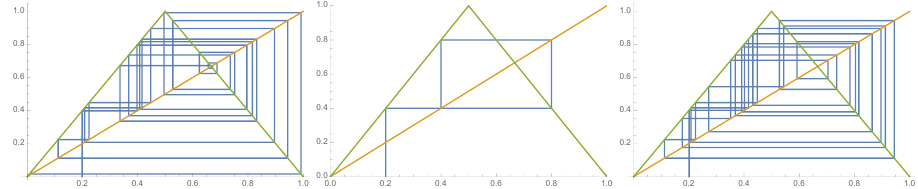
Figure 1. Trajectories of three initial states around the value 0.2 of the dynamical system given by the tent